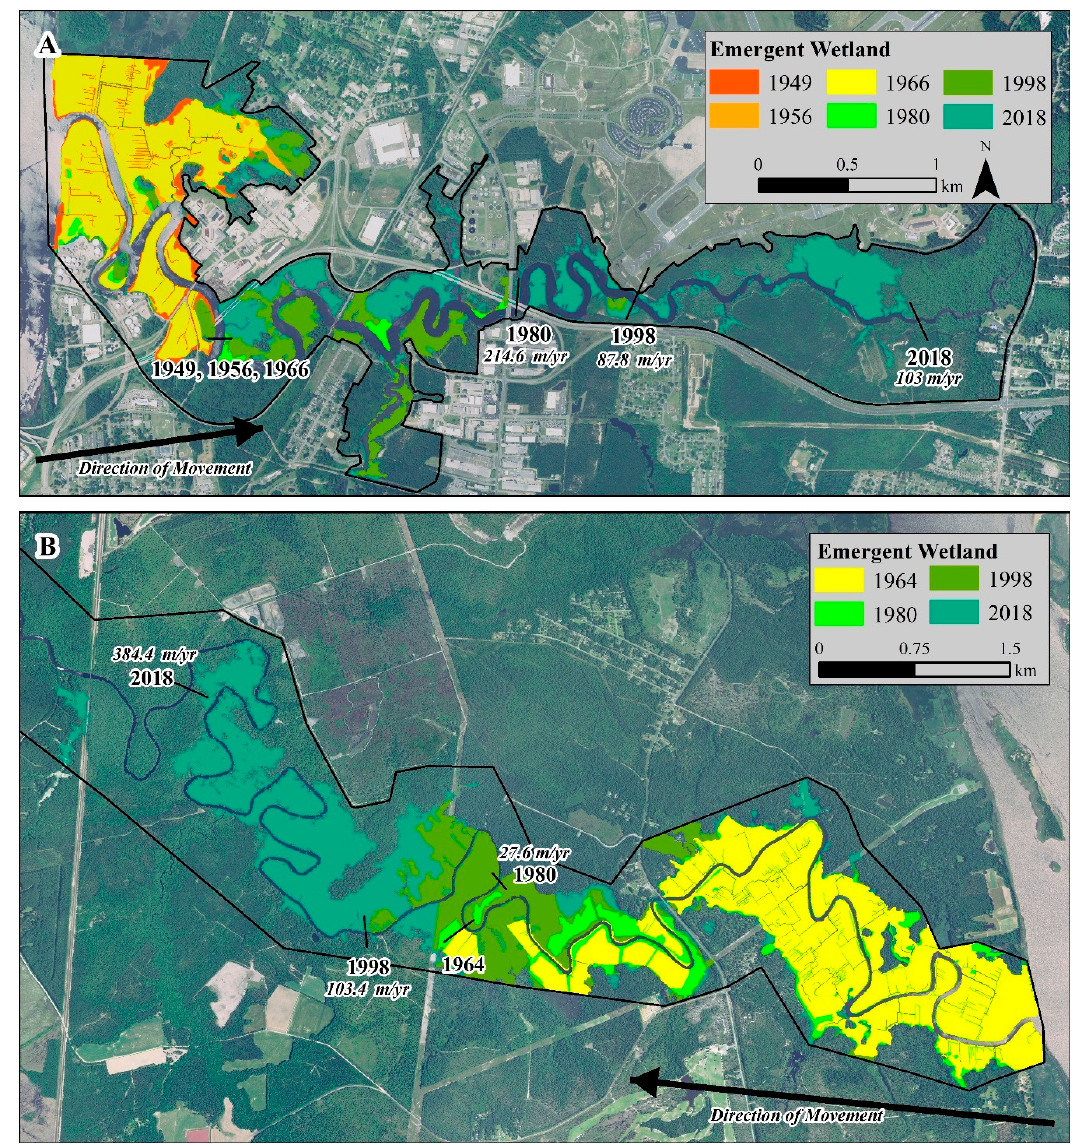
Figure 8. Emergent wetlands through time, where the upstream extent is shown by year and annotated with the rate of movement (m / yr) from the proceeding time period for ( A ) Smith Creek and ( B ) Town Creek.